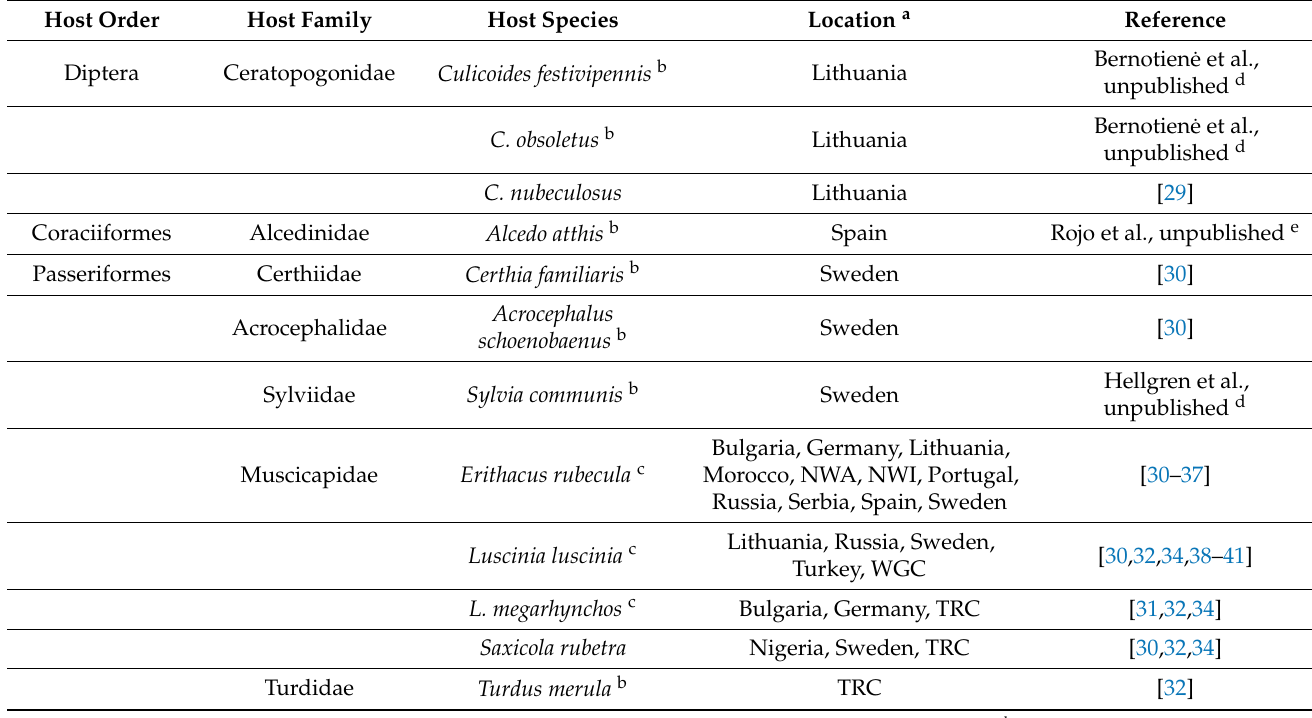
Table 2. Hosts and locations where Haemoproteus attenuatus (cytochrome b lineage hROBIN1) have been reported. Host